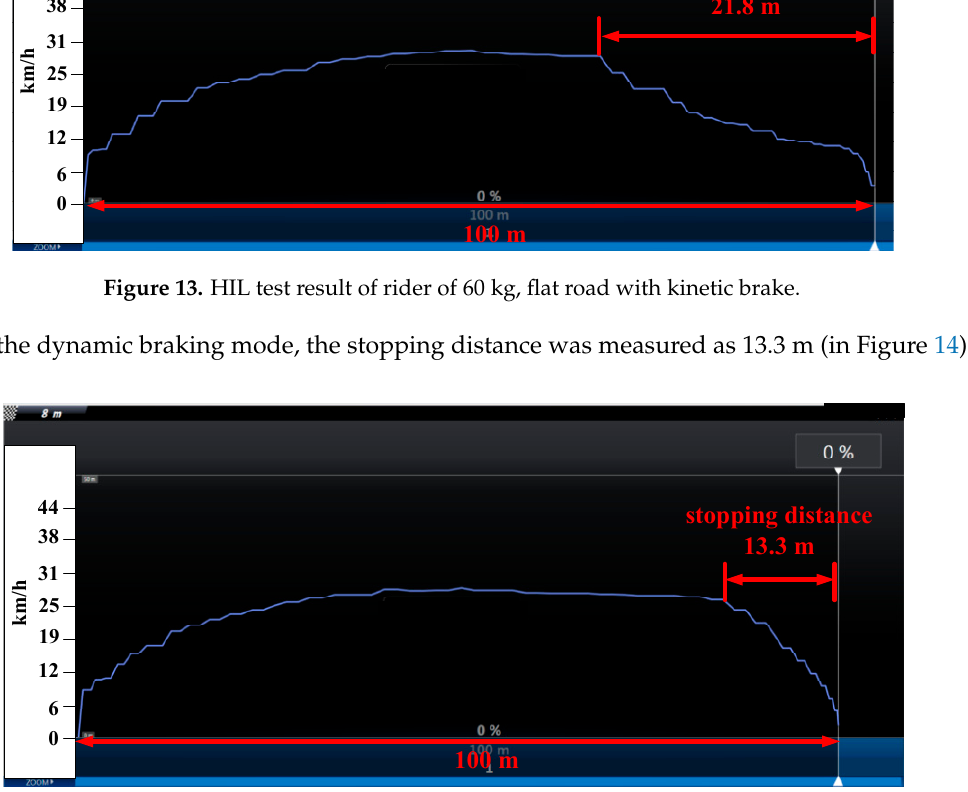
Figure 14. HIL test result of rider of 60 kg, flat road with dynamic brake.